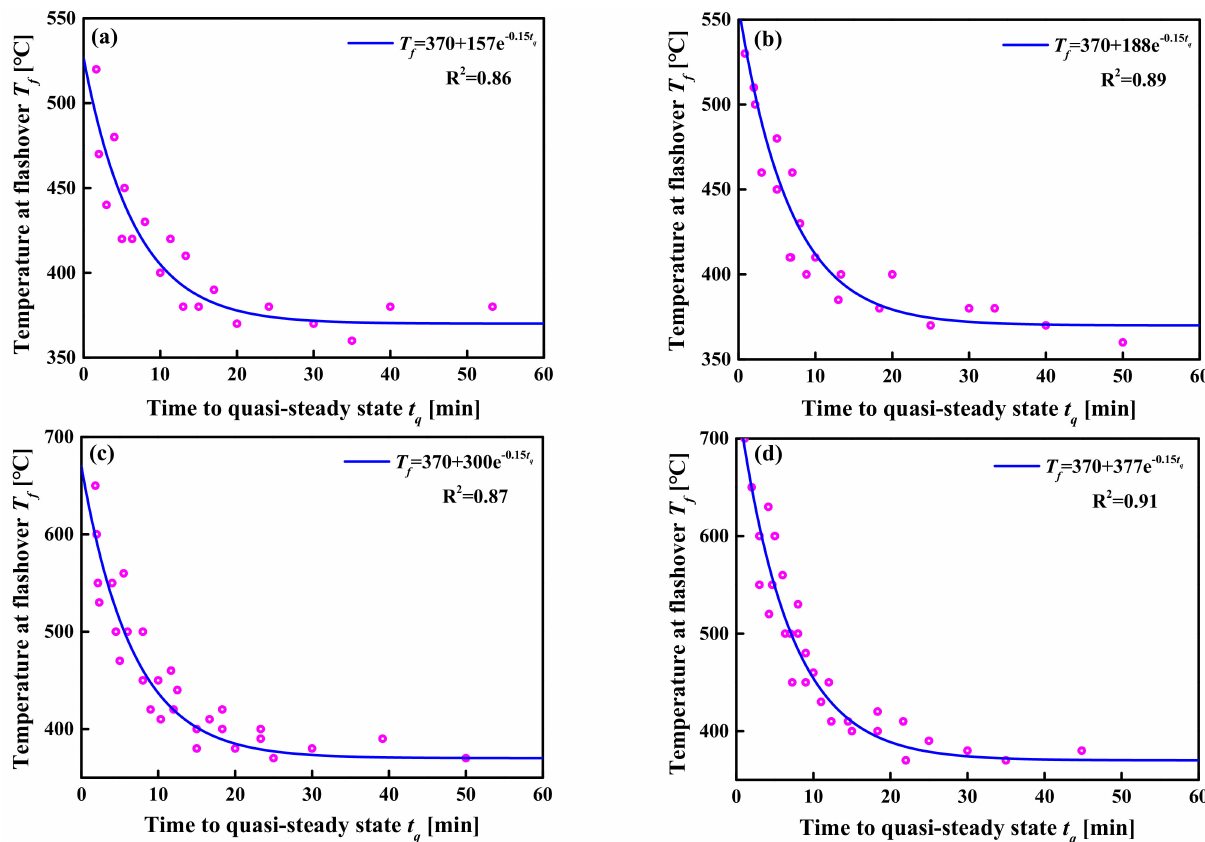
Figure 27. The evolution relationship between the T f and the t q : ( a ) slow fire; ( b ) medium fire; ( c ) fast fire; ( d ) ultra-fast